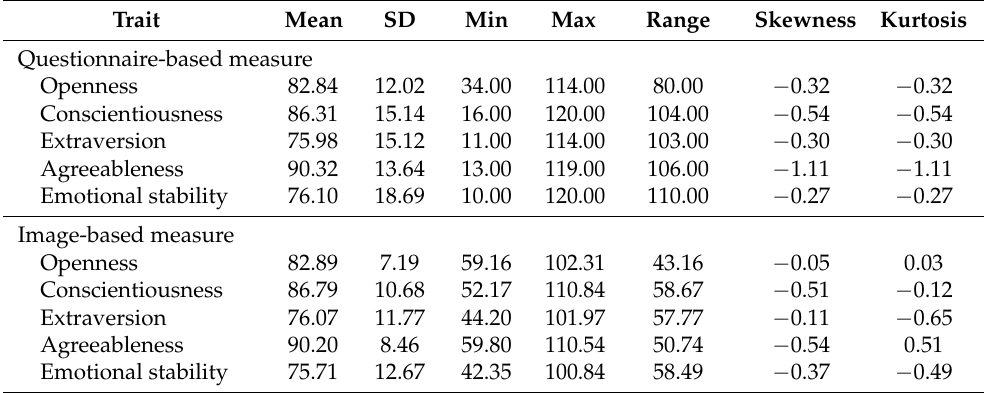
Table 1. The descriptive statistics for the questionnaire- and image-based measures. Trait Mean SD Min Max Range Skewness Kurtosis Questionnaire-based measure Openness